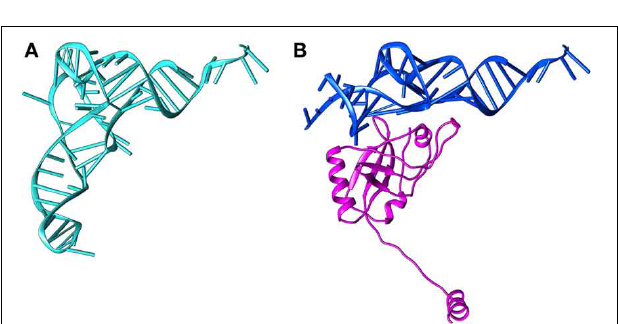
FIGURE 4 | Structural comparison between tRNA and the tRNA-like domain of tmRNA bound to SmpB. (A) The structure of tRNA (PDB entry 2WRN). (B) The structure of TLD-SmpB (PDB entry 4ABR). The TLD is blue and SmpB is magenta. The TLD resembles the upper part of a tRNA, with SmpB replacing the tRNA anticodon stem-loop.